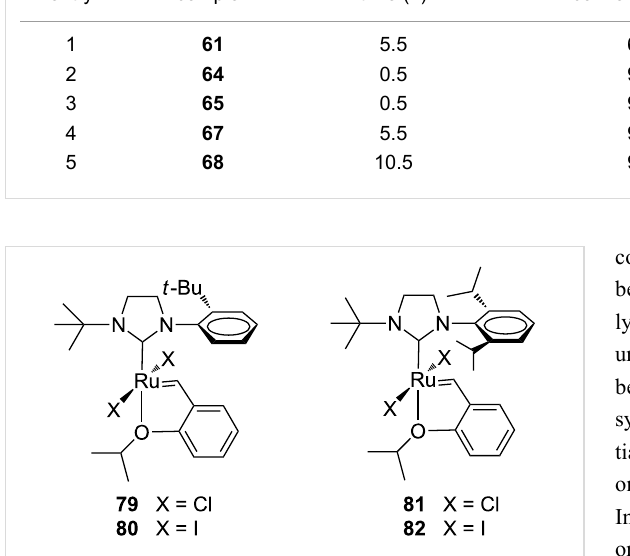
Figure 17: Hoveyda-type catalysts 79 – 82 with N - tert -butyl, N’ -aryl NHCs.